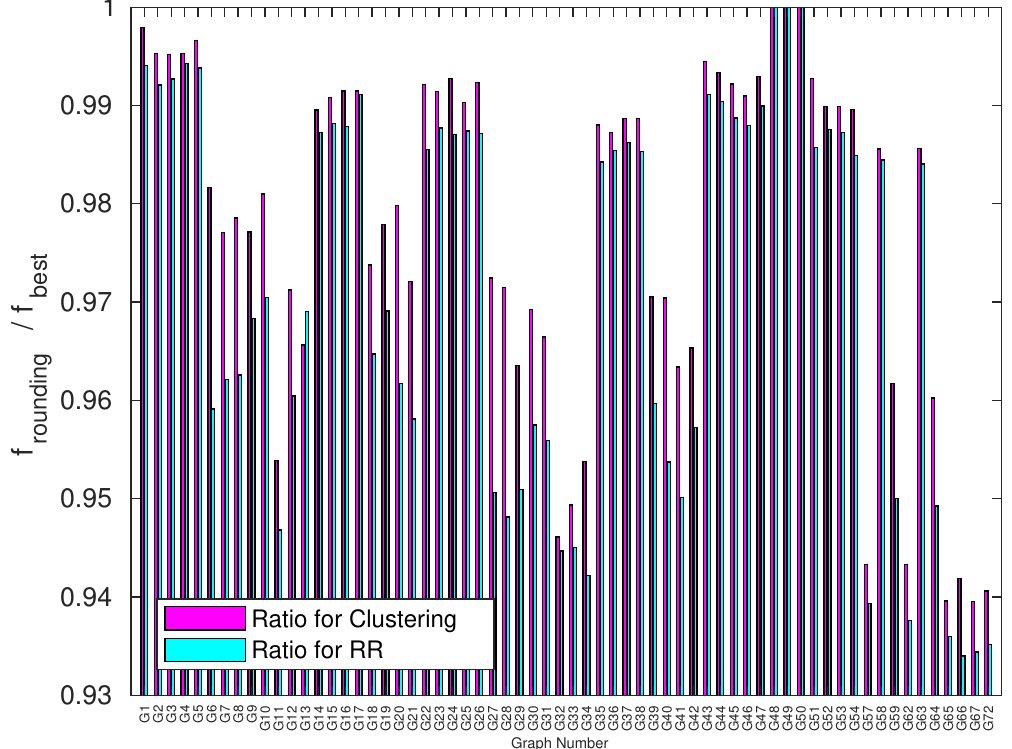
Figure 5. Comparison of the best cut value obtained with clustering (in magenta) and RR (in cyan) and subsequence local improvement with the best cut value ( f best ) available in the